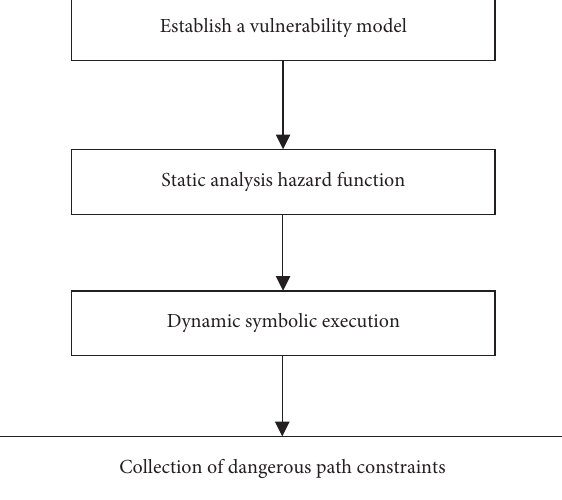
Figure 2: The execution workflow of guided signal processing.